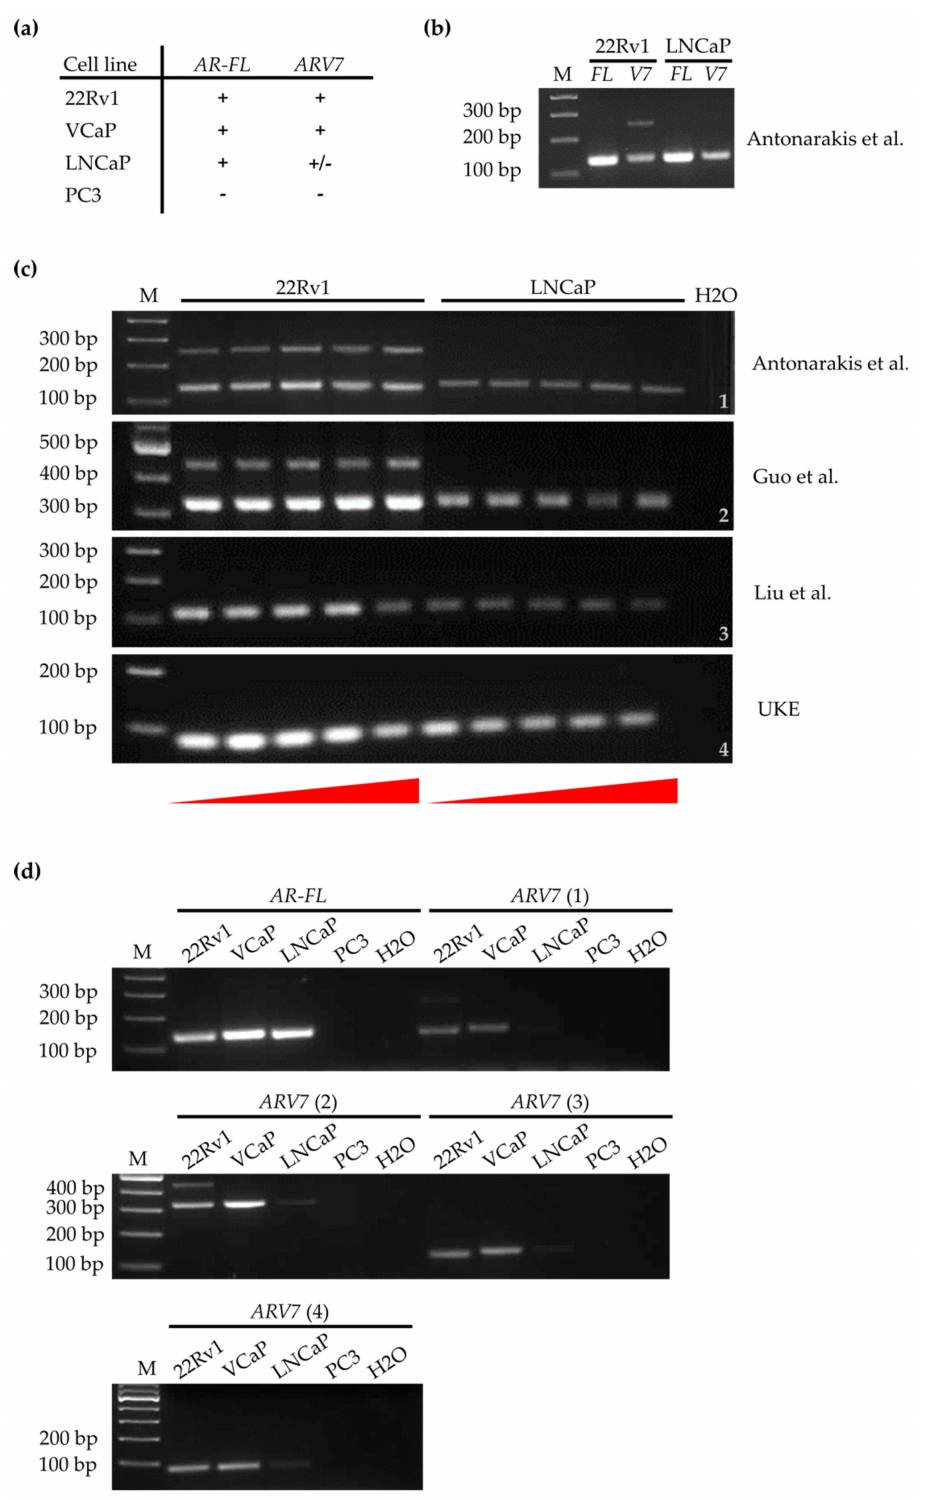
Figure 2. PCR-based detection of AR-FL and androgen receptor splice variant 7 ( ARV7 ) in selected prostate cancer cell lines. Letter M indicating DNA ladder (marker) lanes. Ten nanograms of cDNA were analyzed for each PCR sample. ( a ) Schematic overview of AR-FL and ARV7 positivity ( + ) and negativity ( − ) for established prostate cancer cell lines, as described in literature. ( b ) Agarose gels of a PCR detecting AR-FL and ARV7 in cDNA isolated from 22RV1 and LNCaP cells. ARV7 cDNA was detected using the primers described by Antonarakis et al. [20]. PCRs were performed for 39